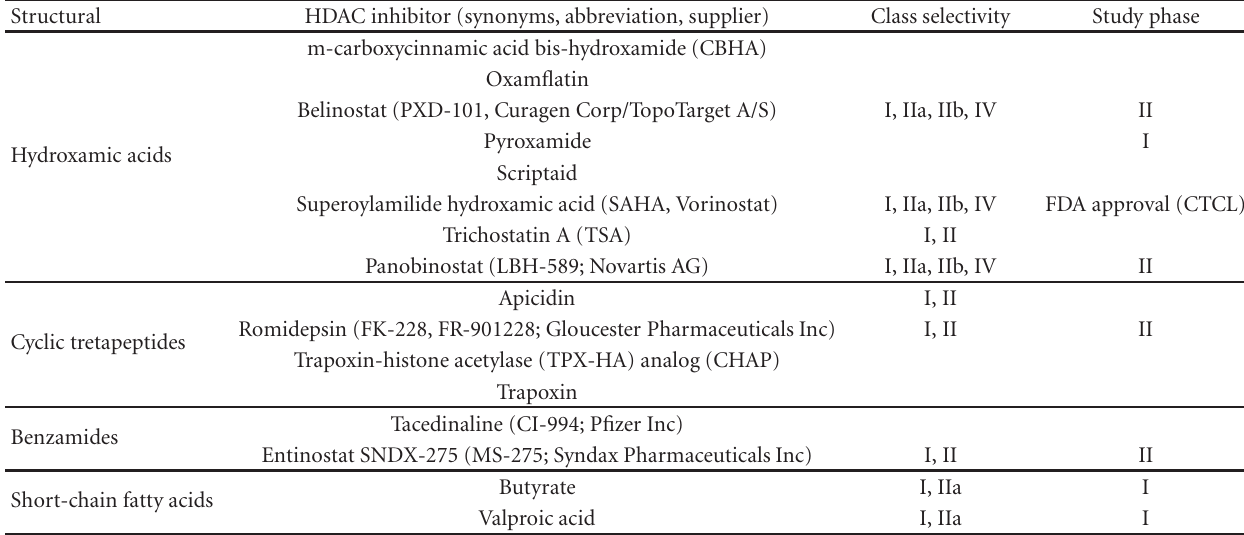
Table 2: Selected HDAC inhibitors: structural class, compound, isotype selectivity, and study phase—an overview (according to Batty et al. [14] and Schneider-Stock and Ocker